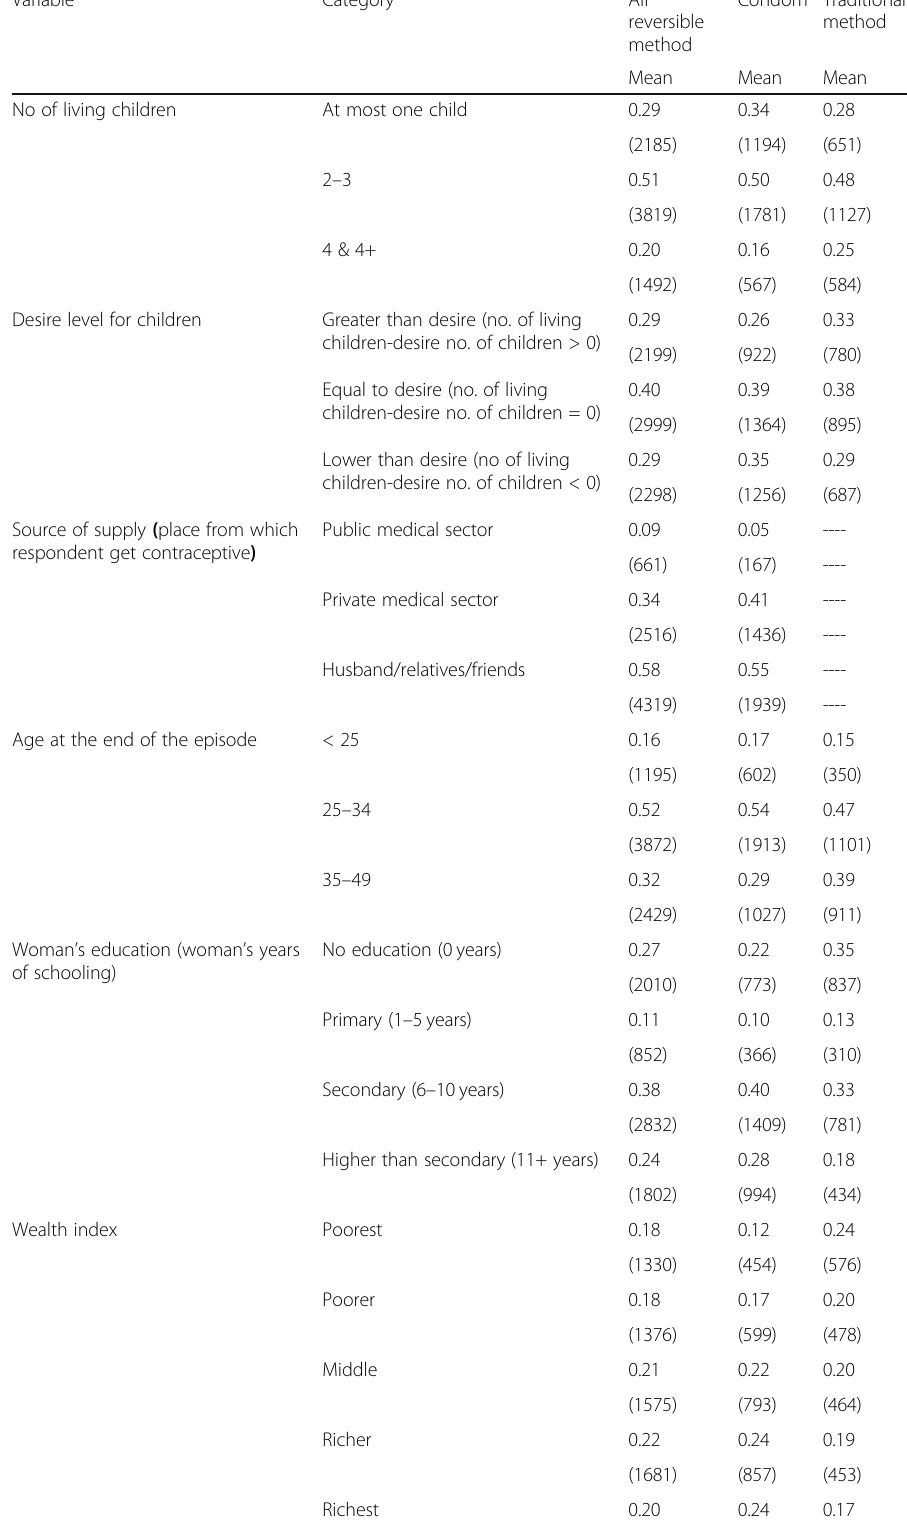
Table 1 Descriptive statistics of the sample variables included in the